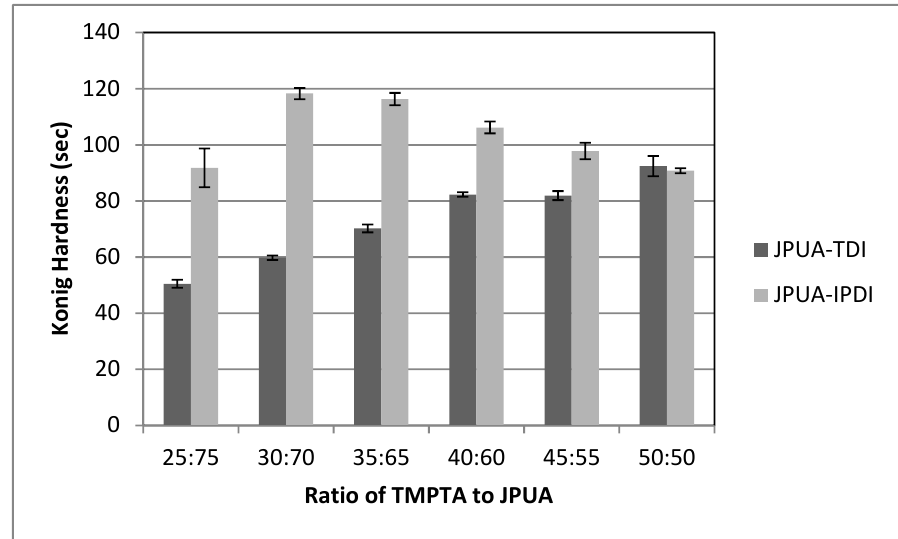
Figure 7. Hardness measurement of JPUA-TDI and JPUA IPDI-based coating.